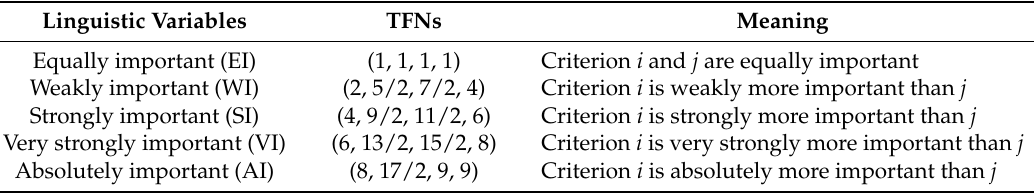
Table 2. Linguistic terms and TrFN numbers comparison.